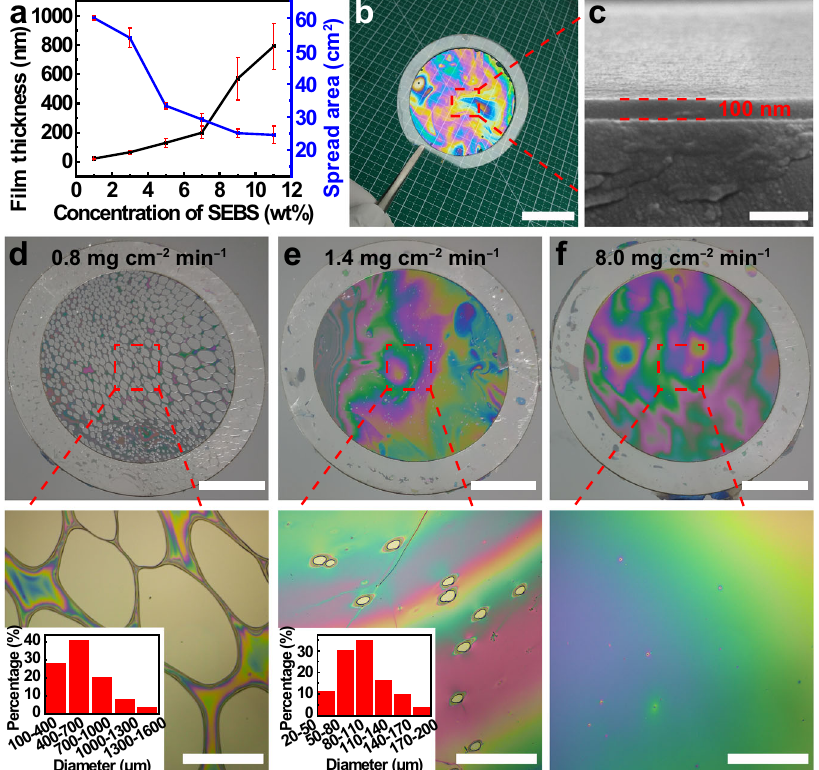
Fig. 3 Fabrication of the ultrathin porous fi lm. a Spread area and thickness of SEBS when 20 μ L SEBS solutions with different concentrations being dropped on the surface of water. b Photograph of a freestanding SEBS fi lm with thickness of 100 nm. Scale bar: 2 cm. c SEM image of the cross section of the SEBS fi lm. Scale bar: 300 nm. d − f SEBS fi lms formed under different evaporation rates of toluene. Scale bars in low magni fi cation graph: 1 cm; Scale bars in high magni fi cation graph: 500 μ